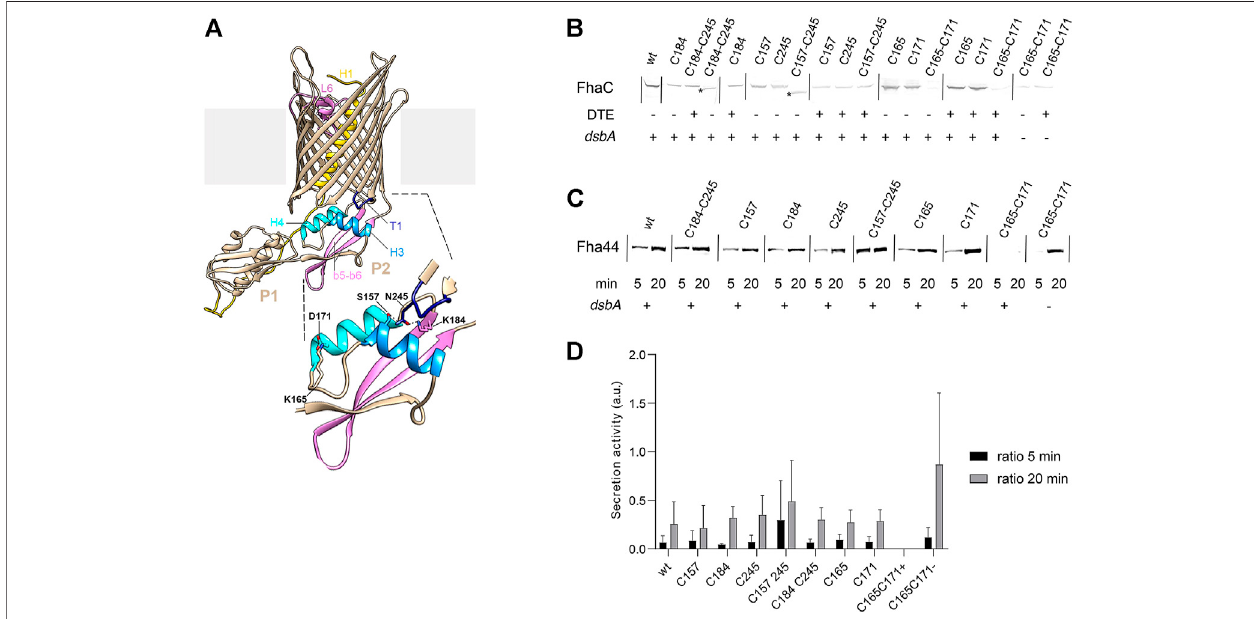
FIGURE 7 | Effects of engineered S-S bonds on FhaC activity. (A) Structural model of FhaC with a zoom of the POTRA2 domain shown below. (B) Residues involvedinasaltbridge(Lys 165 -Asp 171 )orHbonds(Lys 184 -Asn 245 ;Ser 157 -Asn 245 )intherestingconformationofFhaCwerereplacedasindicated(C=Cys).Immunoblots wereperformedonmembraneextractswithanti-FhaCantibodies.Theasterisksindicateoxidized species ofFhaCdetected intheabsenceofthereducingagentDTEin thesamplebuffer. (C) Thesecretion activity oftheFhaC variantswasdeterminedusingamodelsubstrate,Fha44-His,af fi nityprecipitatedfromsupernatants5and 20 min after induction. Immunoblots were developed with an anti-6His tag monoclonal antibody. (D) Quanti fi cation of Fha44 found in culture supernatants after 5 and 20 min, normalized by the expression levels of the respective FhaC mutants. The means and standard deviations of the means are shown (n = 3 or 4). Activity of FhaC C165+C171 could only be detected in the dsbA KO strain (denoted C165-C171 (-)), not in its wild type parent (denoted C165-C171 (+)).